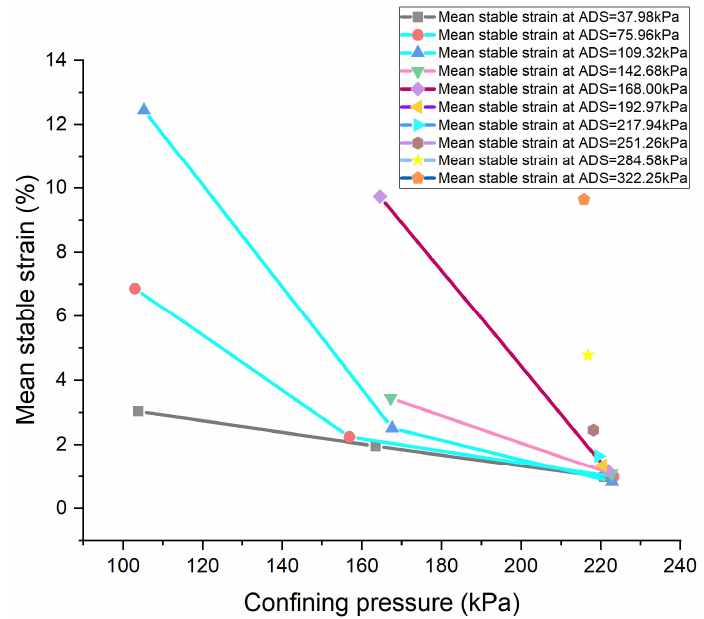
Figure 41. The mean stable strain under the preset axial deviatoric stresses withstanding different confining pressures.